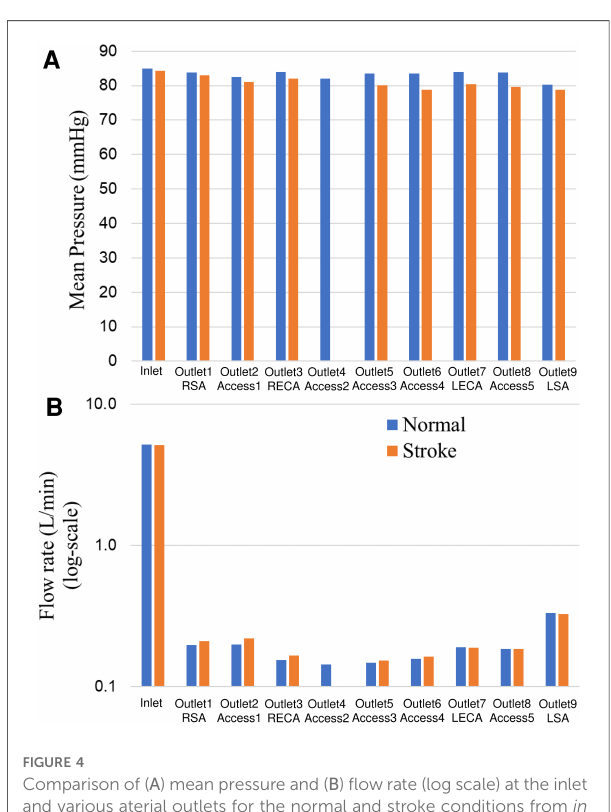
FIGURE 4 Comparison of ( A ) mean pressure and ( B ) fl ow rate (log scale) at the inlet and various aterial outlets for the normal and stroke conditions from in vitro experiments. The values of pressure and fl ow rate at outlet 4 for the stroke condition are zero because there is no fl ow due to the blockage.